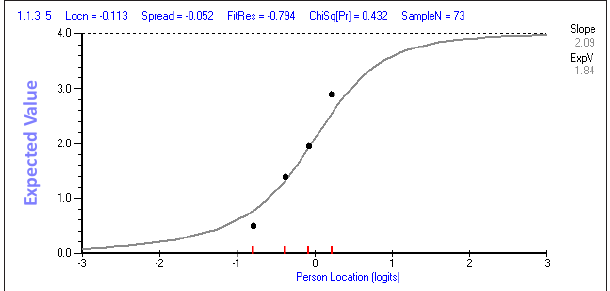
FIGURE 12: Initial item characteristic curve for item 1.1.3.